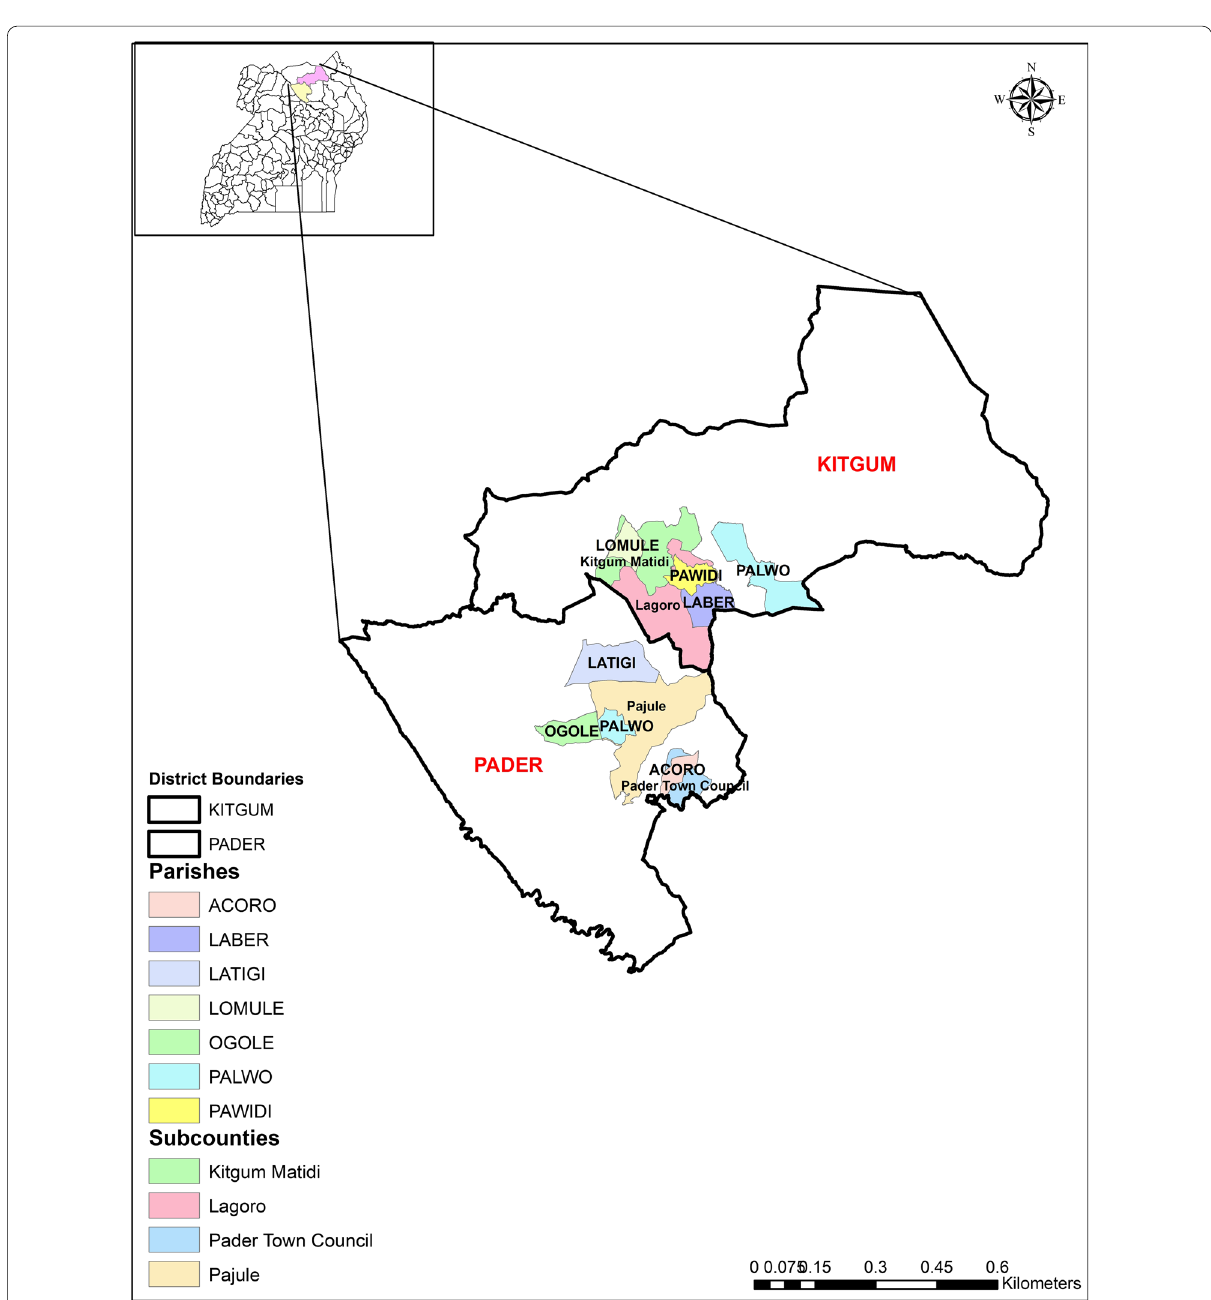
Fig. 1 Location of parishes surveyed for plants used in managing symptoms of TB in Kitgum and Pader districts, Uganda. The map was created by the authors using ArcGIS version